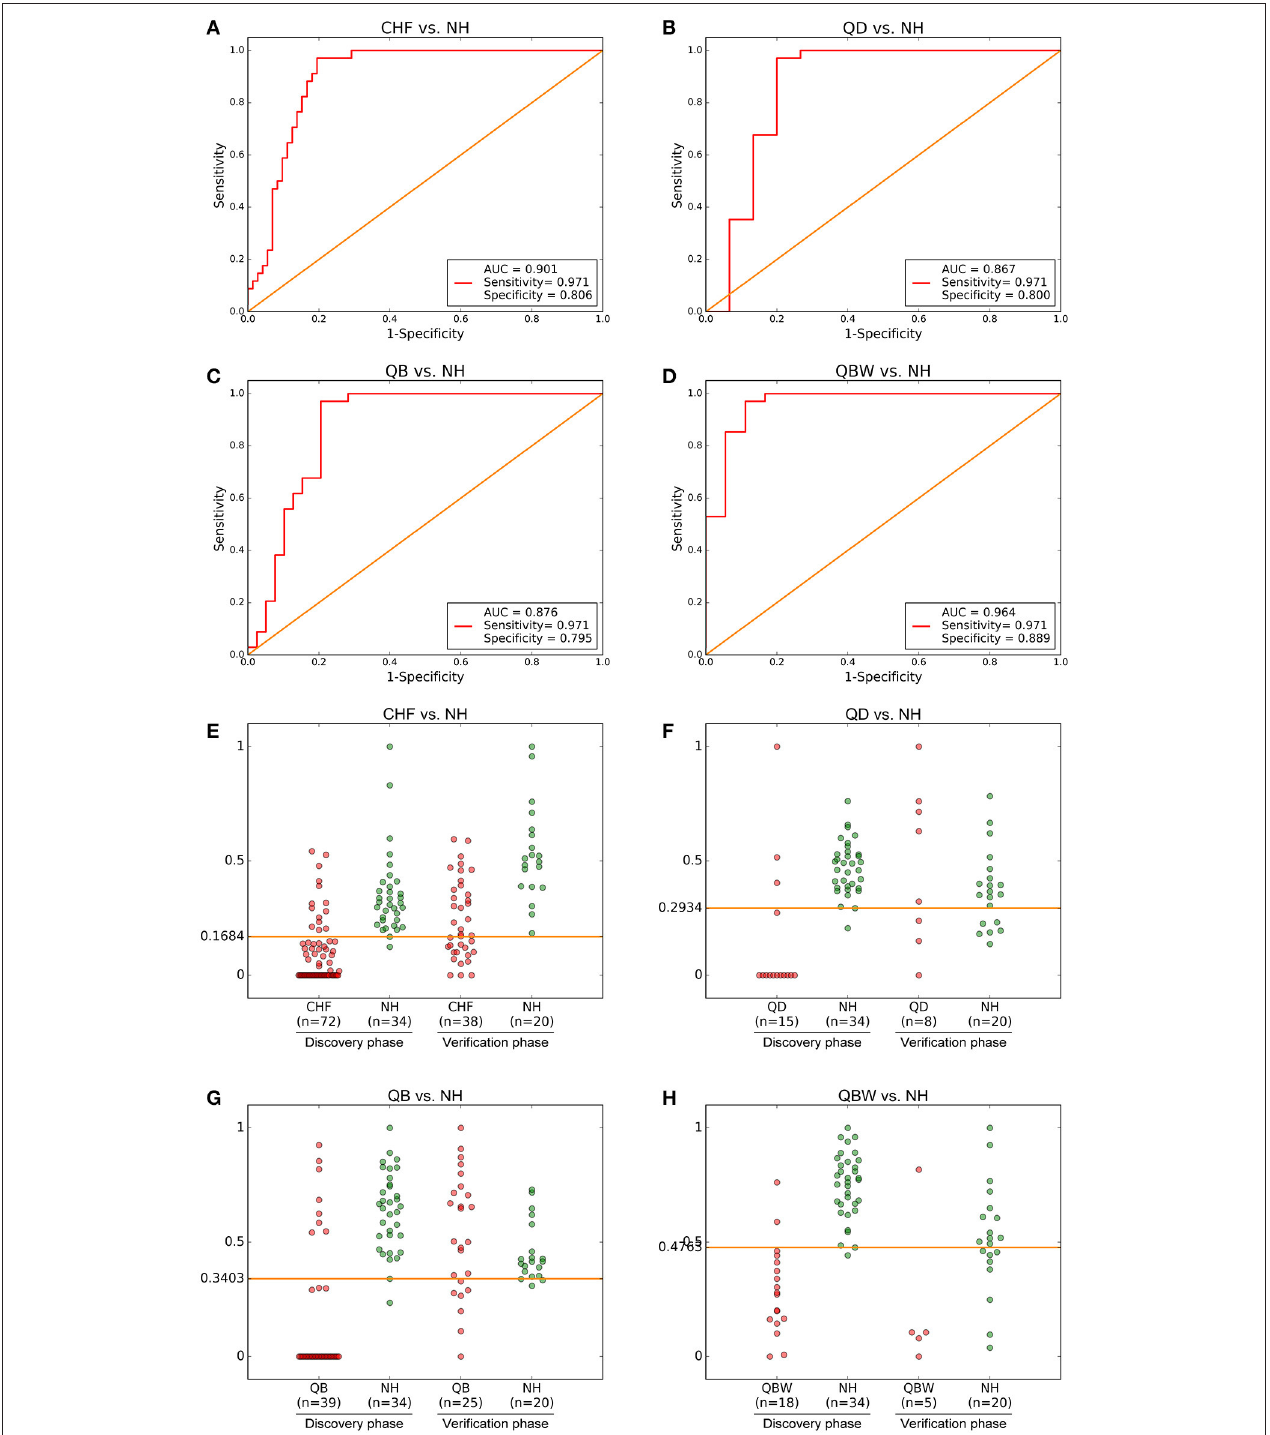
FIGURE 3 | Diagnostic Outcomes and Predictive Accuracies. The diagnostic outcomes in the discovery phase are shown via the receiver-operating characteristic (ROC) curves for comparison between (A) CHF vs. NH, (B) QD vs. NH, (C) QB vs. NH, and (D) QBW vs. NH. The predictive accuracies by the biomarkers in validation phase and validation sets were compared between (E) CHF vs. NH, (F) QD vs. NH, (G) QB vs. NH, and (H) QBW vs. NH. AUC, Area Under the Curve; CHF, Chronic heart failure; NH, Normal healthy group; QD, Qi deficiency group; QB, Qi deficiency and Blood stasis group; QBW, Qi deficiency and Blood stasis and Water retention